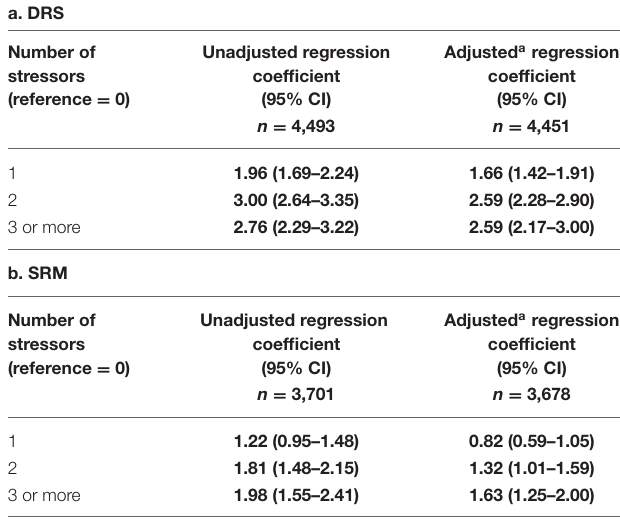
TABLE 4 | Overview of the association between the presence of one or more stressors and: a. observer-reported mood (DRS); b. self-reported mood (SRM) in the subpopulation with SRM